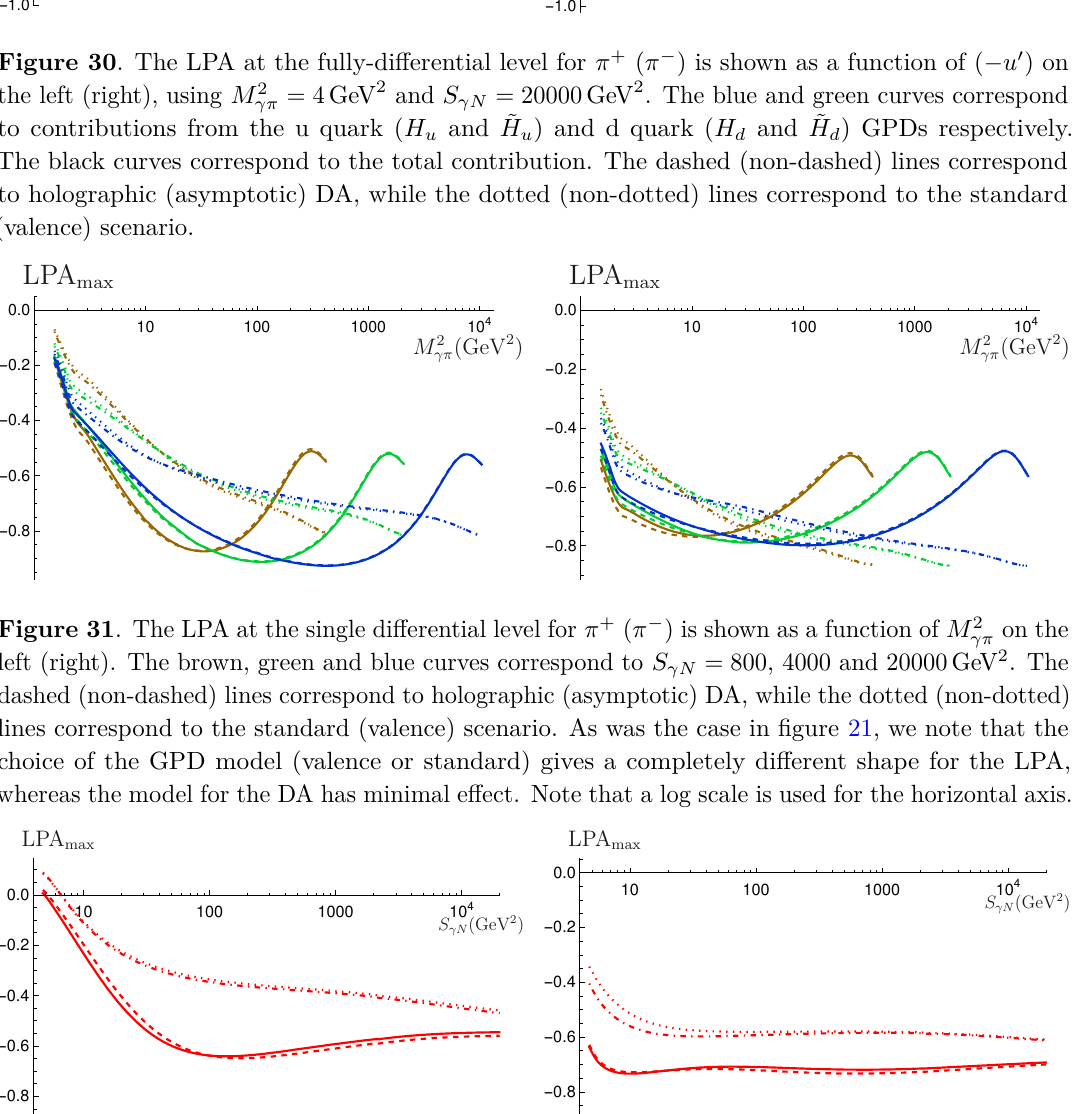
Figure 32 . The LPA integrated over all differential variables for π + ( π − ) is shown on the left (right) as a function of S . The dashed (non-dashed) lines correspond to holographic (asymptotic) γN DA, while the dotted (non-dotted) lines correspond to the standard (valence) scenario.